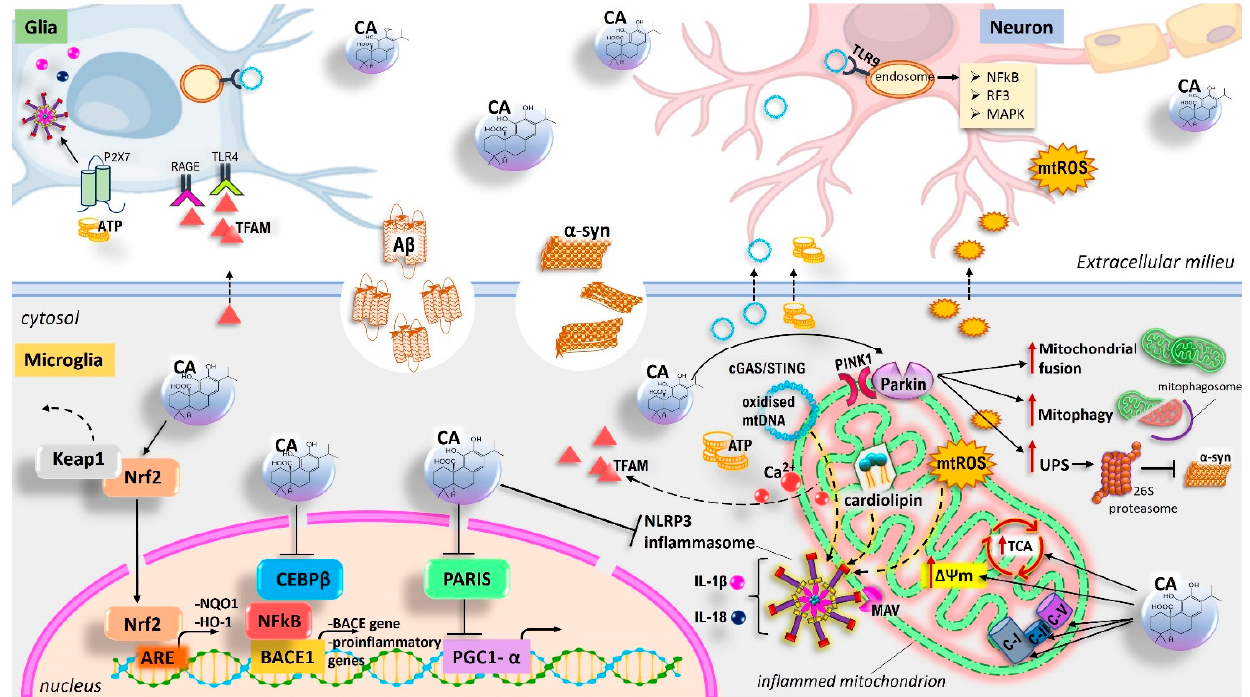
Figure 3. Current model of multi-target protective effects of carnosic acid (CA) at the interface of mitochondrial dysfunction, neuroinflammation, and neurodegeneration. Upon stressful conditions, including oxidative injury, accumulation of altered/misfolded proteins, and inflammatory stimuli, mitochondria are impaired with ensuing release of mitochondrial-derived DAMPs (mtDAMPs) such as ROS, Ca 2+ , oxidized mtDNA, cardiolipin, ATP, and transcription factor A mitochondria (TFAM). In surrounding neurons and glial cells, mtDAMPs bind to TLR9, purinergic P2X7 receptor, RAGE, and TLR, promoting further mitochondrial damage and triggering pro-inflammatory, pro- apoptotic cascades that contribute to exacerbation of proinflammatory microglial activation, with the consequent degeneration of dopaminergic neurons. CA provides neuroprotective effects, decreasing oxidative stress by upregulating antioxidant defence, reducing the expression of proinflammatory cytokines via inhibiting the NF κ B pathway and/or NLRP3 inflammasome activation, and preserving mitochondrial function. Therefore, Keap1 degradation and Nrf2/HO-1/NQO1 signalling pathway activation, upregulation of the PINK1/parkin pathway, and modulation of the PARIS/PGC-1 α axis contribute to counteracting oxidative stress and energy imbalance, as well as mitochondrial disruption by promoting mitophagy, mitobiogenesis, mitochondrial fusion, and UPS machinery. Additionally, CA decreases the CEBP β –NF κ B interaction and reduces A β aggregation/deposition by inactivating the amyloidogenic proteolytic pathway of amyloid precursor protein (APP). Moreover, the ATP and TFAM released from neuron/glia extracellularly promote proinflammatory microglial activation by interacting, respectively, with the purinergic P2X7 receptor (inducing the activation of NLRP3 inflammasome) and advanced glycation end-products (RAGE) or TLR4 (upregulating the levels of NF- κ B) on the membrane